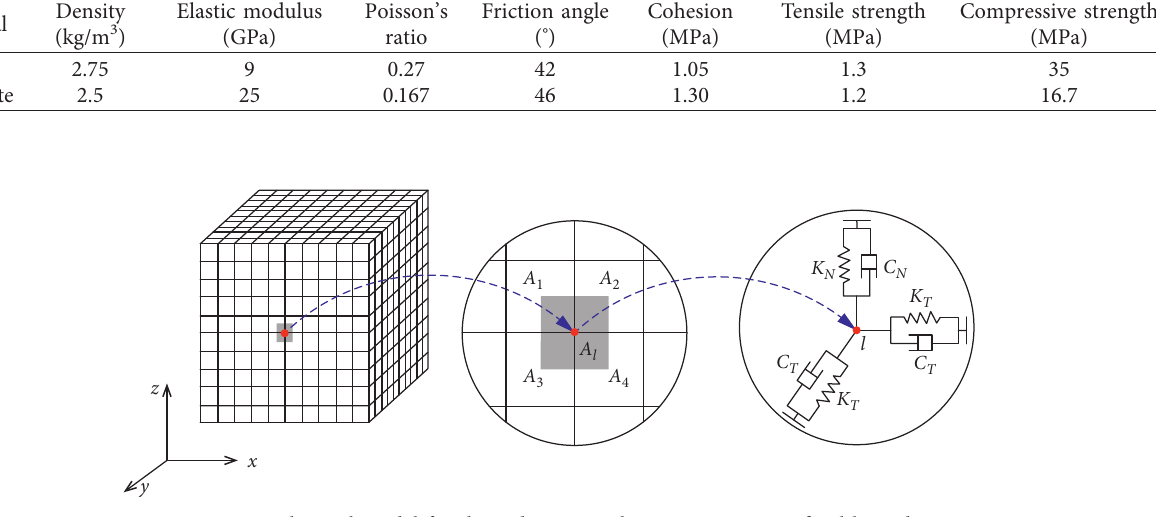
Figure 4: Mechanical model for three-dimensional viscous-spring artificial boundary.